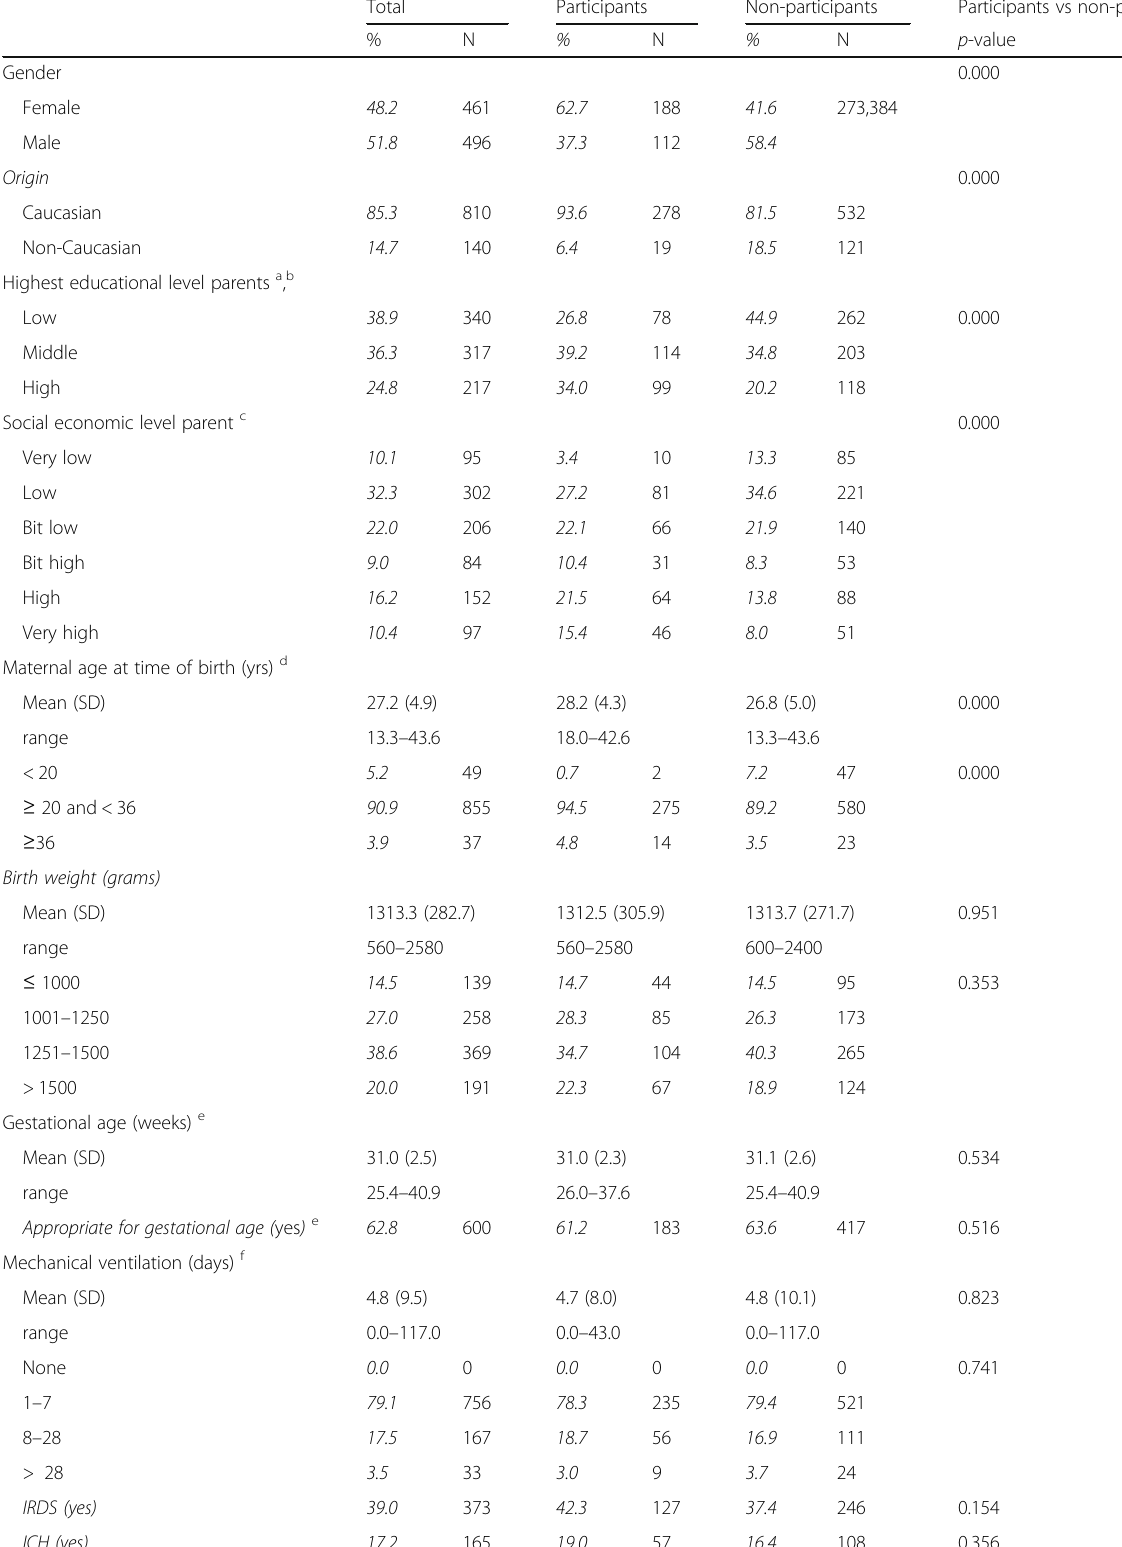
Table 1 Demographic and Neonatal characteristics: participants versus non-participants Total Participants Non-participants Participants vs